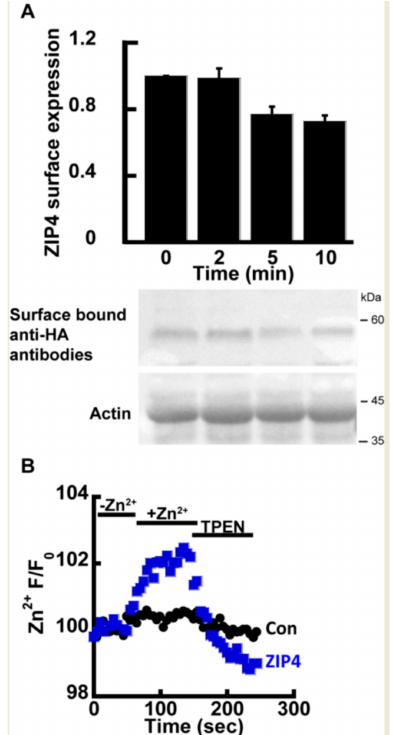
Figure 1. ZIP4 Zn 2 + transport assay. ( A ) Immunoblot analysis (Lower panel) and normalized surface expression by densitometry (upper panel) of HEK293-T cells transfected with hemagglutinin (HA)-tagged mZIP4 and exposed to 20 µ M Zn 2 + for the indicated times N ≥ 5. ( B ) Experimental assay used to monitor Zn 2 + uptake in HEK293-T cells transfected with an empty control vector (black) or mZIP4 (blue) N ≥ 5. Cells were loaded with 1 µ M Fluozin-3AM and subjected to 50 µ M Zn 2 + and 20 µ M TPEN, as